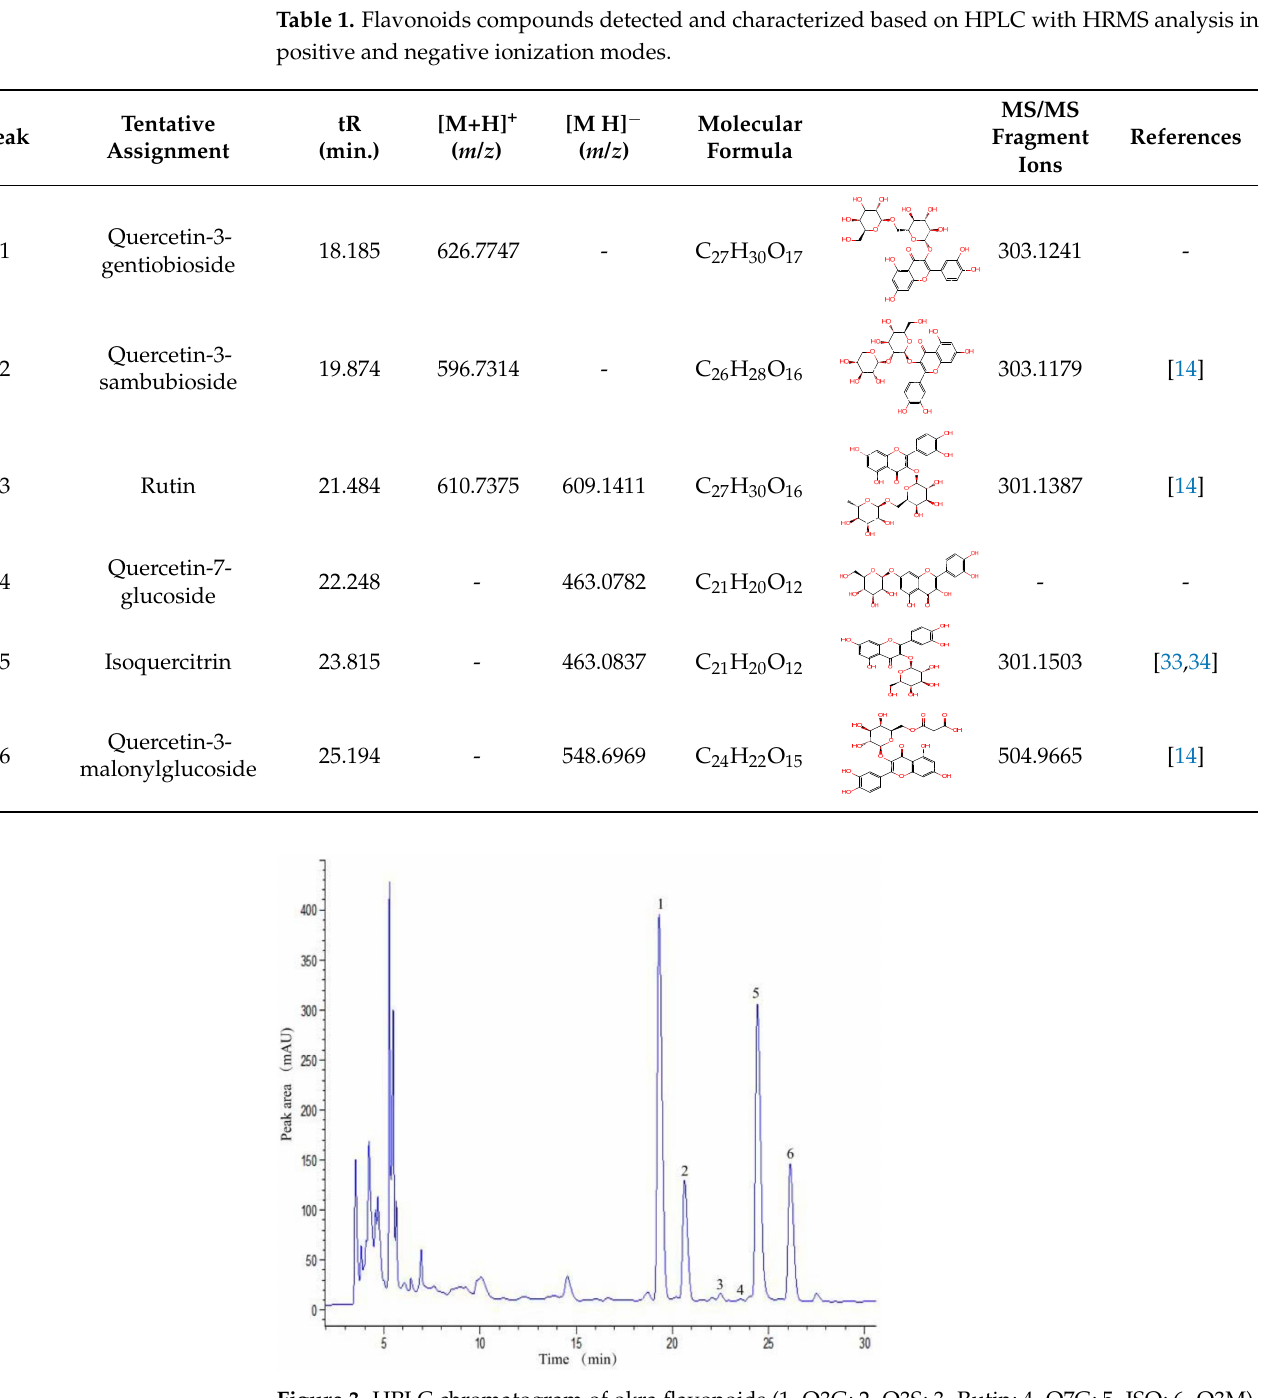
Figure 3. HPLC chromatogram of okra flavonoids ( 1. Q3G; 2. Q3S; 3. Rutin ; 4 . Q7G; 5. ISO; 6. Q3M) .